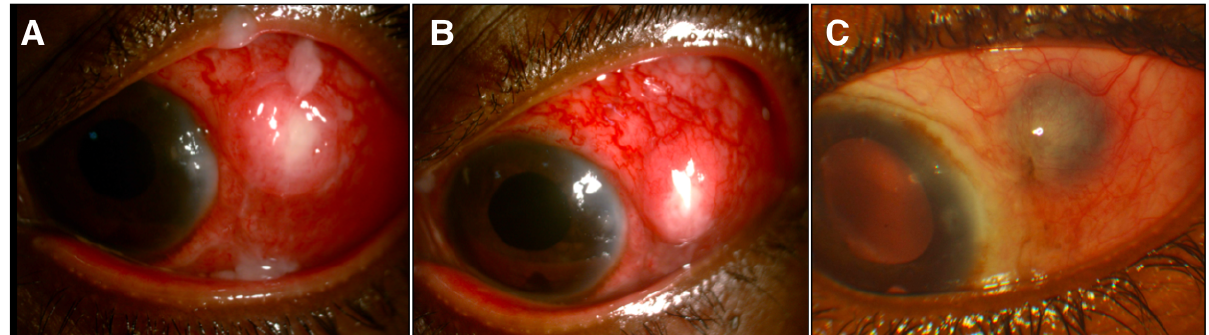
Figure 1: Surgically induced necrotizing scleritis at the sclerotomy site after vitrectomy. With intense conjunctival congestion, exudation at the sclerotomy site and presence of discharge on the fifth postoperative day, scleral abscess was suspected (A). After intense systemic and topical steroid therapy, resolving necrotizing scleritis with reduction in prominence of scleral induration can be seen at 1 week (B). At two months, scleritis has resolved completely with consequent scleral thinning (C). Uveal show can also be